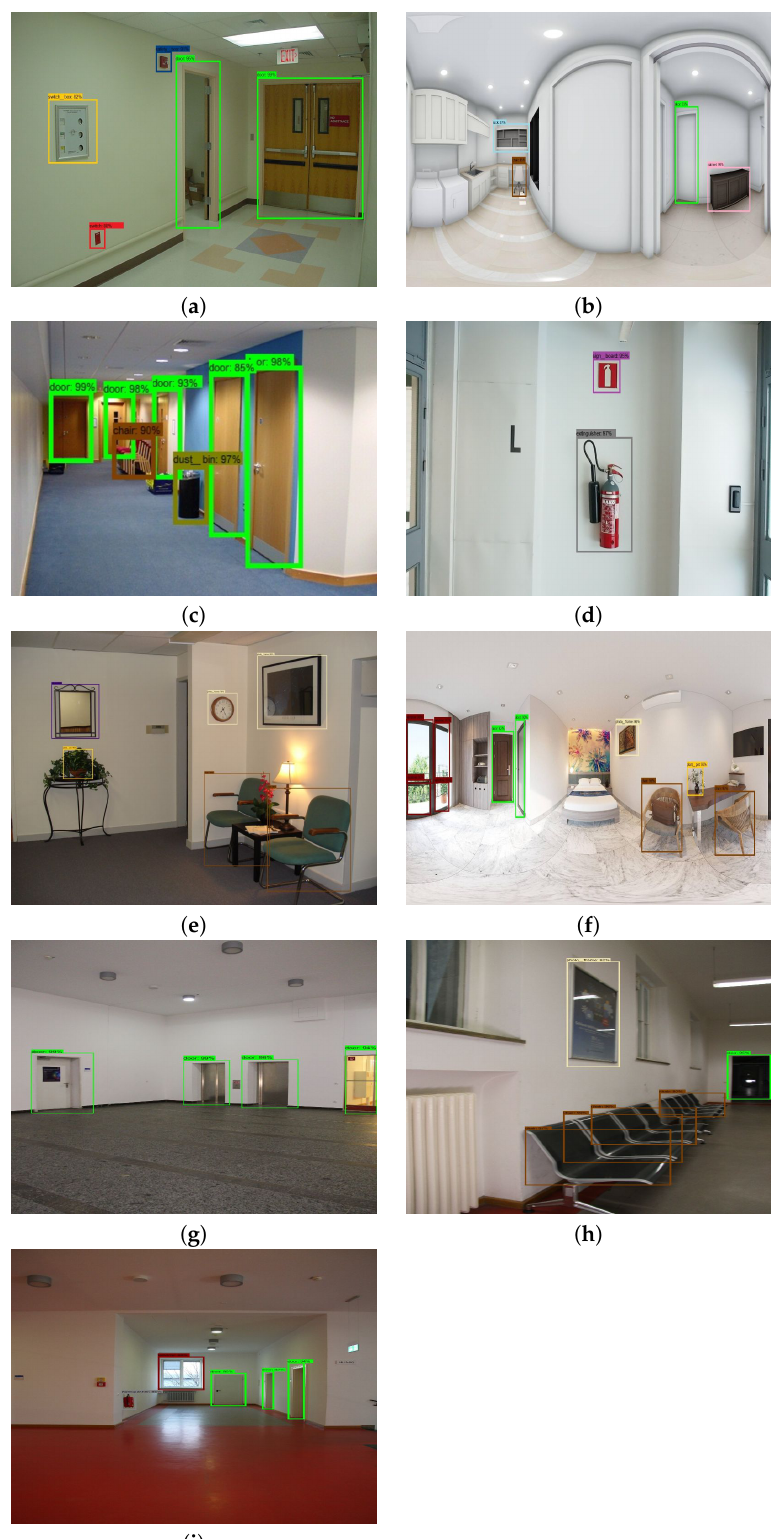
Figure 15. Offline experiment SSD MobileNet Obstacle detection